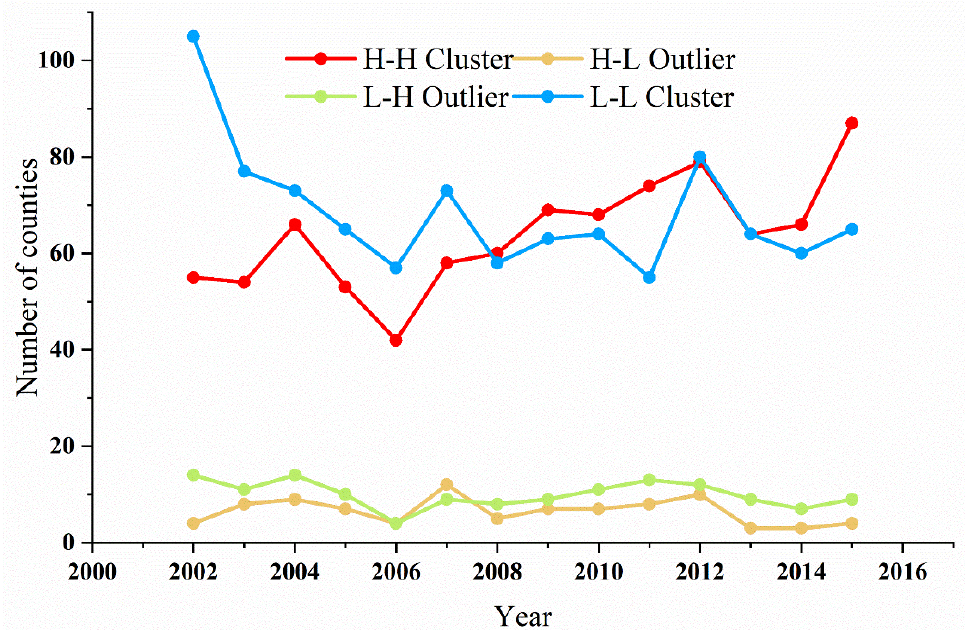
Figure A2. Quantitative changes of four LSA states of EEoSLCP in counties, 2002 to 2015.